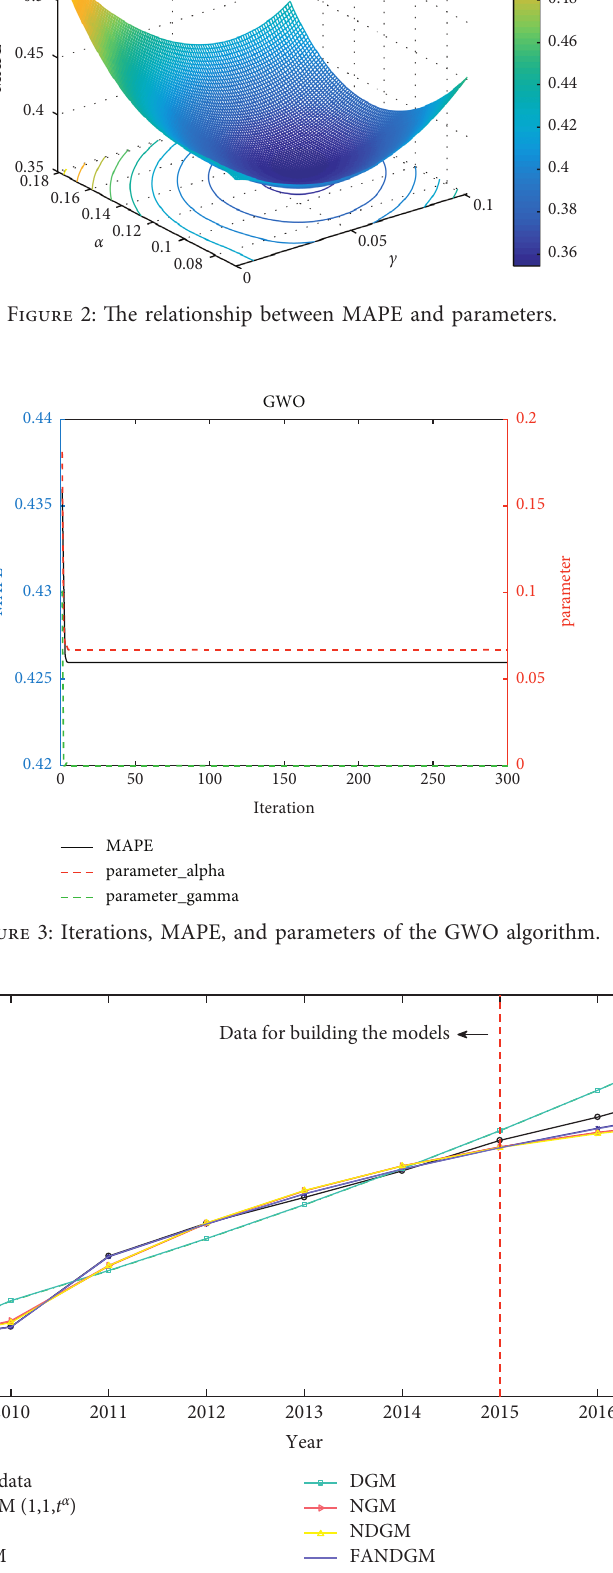
Figure 4: Results of total energy consumption of civil